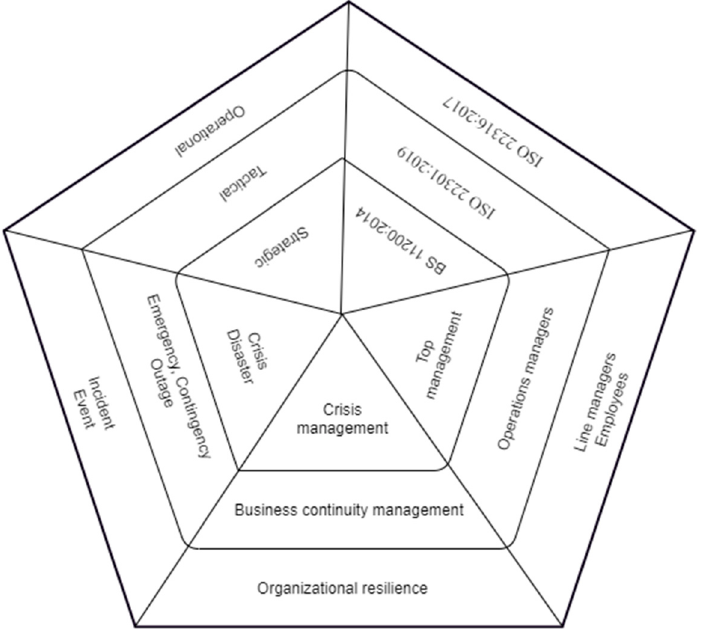
Figure 1. A standard-based concept of the integration of corporate recovery management systems based on a pentagonal pyramid. Source: [14].